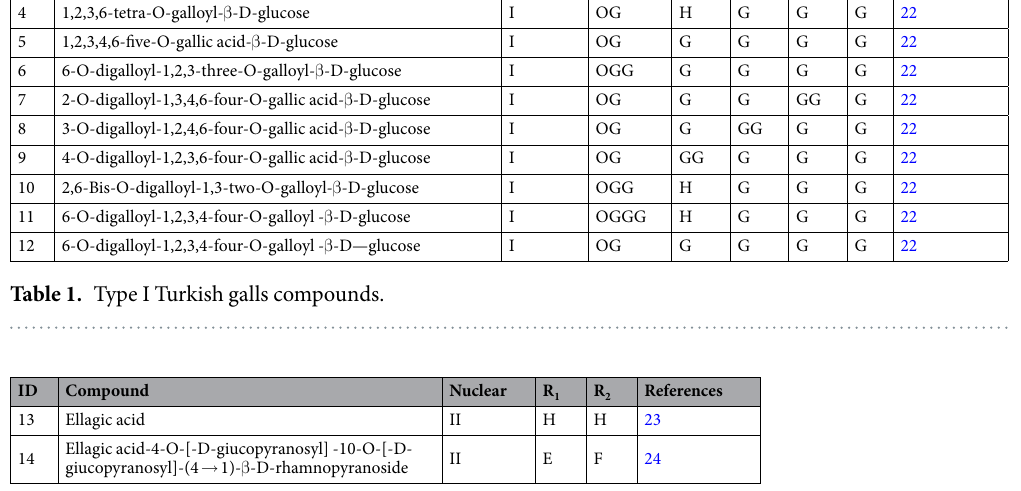
Table 2. Type II Turkish galls